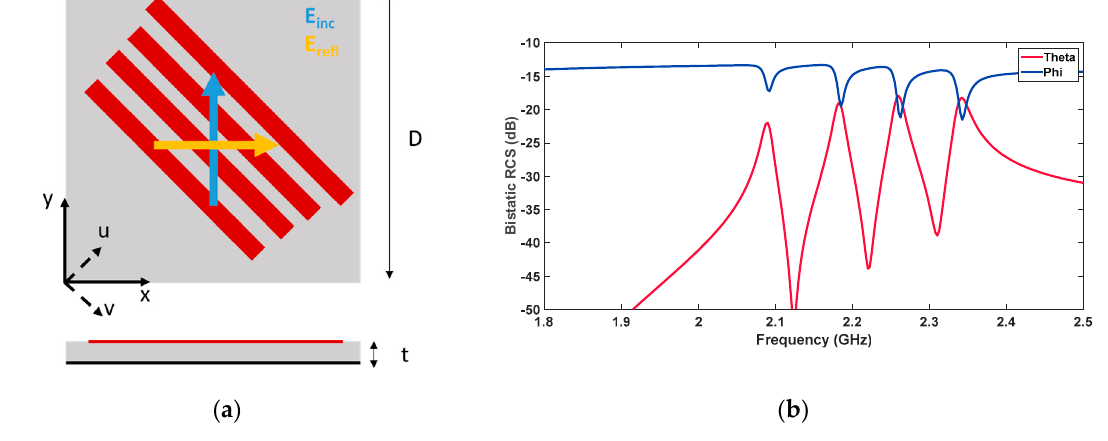
Figure 4. Simulated frequency response of a 1 × 1 tag.